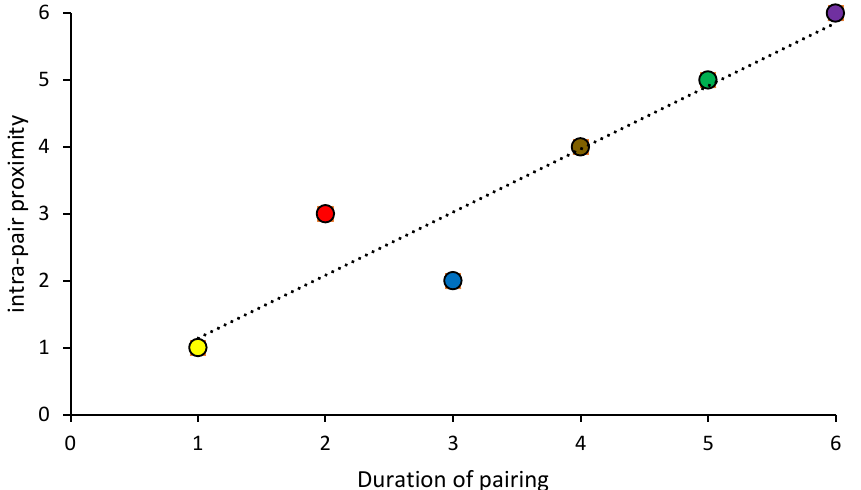
Figure 7. Relationships between duration of pairing and intra-pair proximity based on Zoo Monitor data. For duration of pairing, 1 = together the longest, 6 = most recently established pair. The longer pairs have been together, the more time they spend with one another (Spearman Rho rank correlation, 0.94).